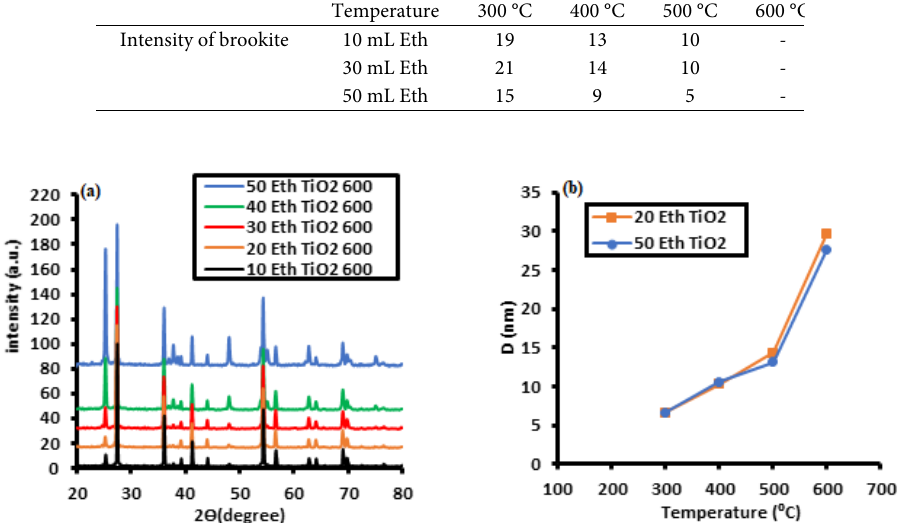
Table 1. Relative intensity of brookite prepared by different volumes of ethanol and calcined at different temperatures.